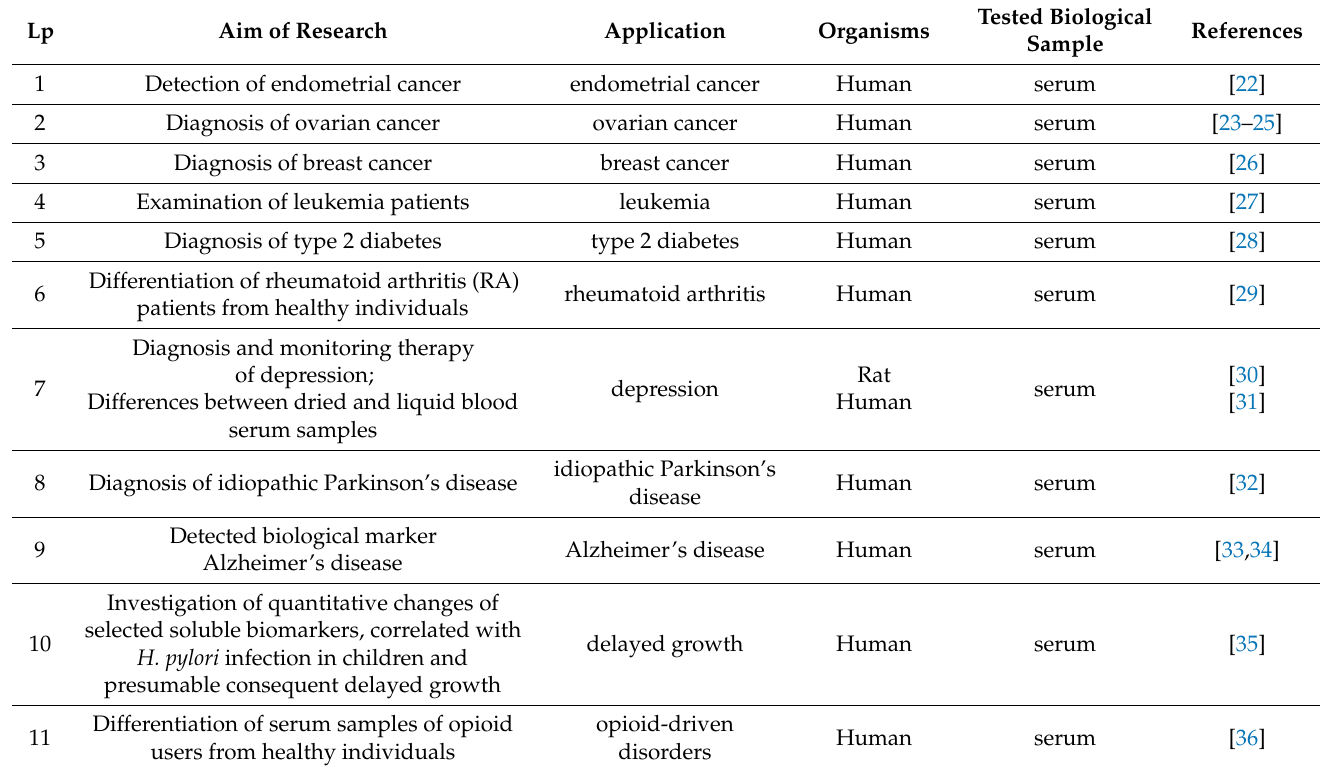
Table 1. Selected examples of the use of attenuated total reflectance-infrared spectroscopy (ATR-IR) in biological samples analysis. Lp Aim of Research Application Organisms